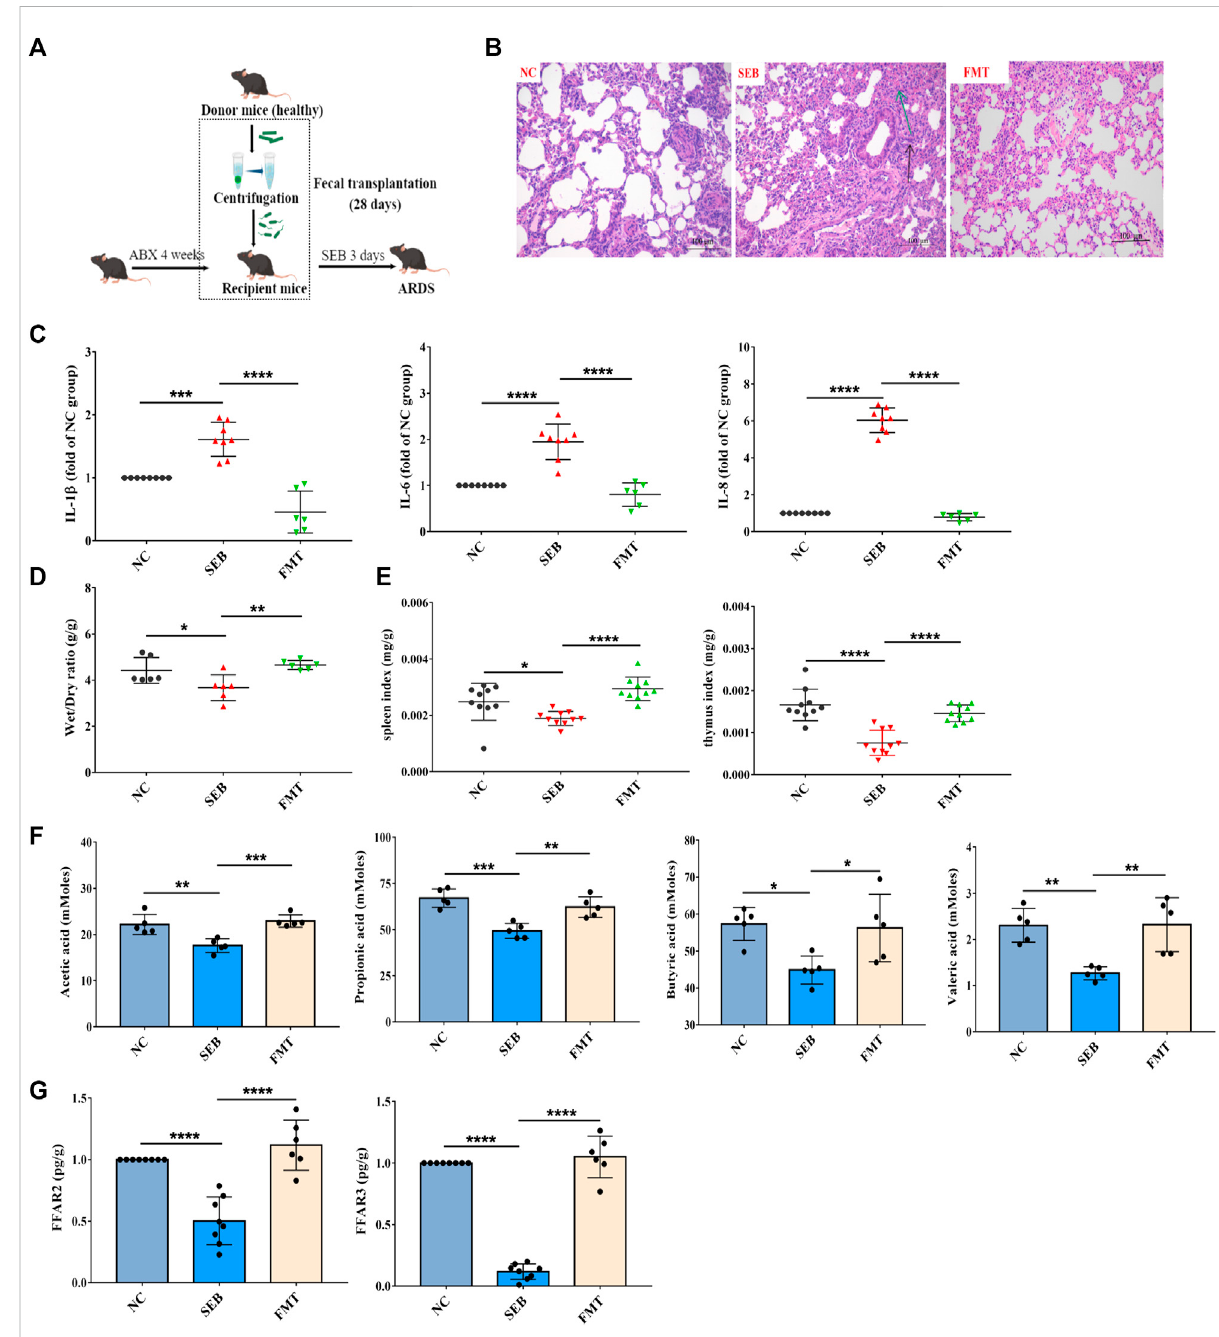
FIGURE 4 Effects offaecal microbiota transplantation (FMT) on microbiota reconstitution andARDS pathogenesis. (A) Schematicdiagram ofFMT inARDS mice. (B) Thepathologicalchangesofparaf fi nsections oflungtissuesweremeasuredbyH&Estaining.Scale=200 μ m. (C) Levelsofthreecytokines from the lung tissue ( n = 6 – 8). (D) The lung wet/dry ratio ( n = 6). (E) The organ index of spleen and thymus ( n = 10). (F) Change of content of acetic acid, propionic acid, butyric acid and valeric acid in the feces ( n = 5). (G) Change of mRNA expression of FFAR3 and FFAR2 ( n = 6 – 8). Data have been presented as means ± SD. Statistical analysis was carried out using one-way ANOVA. * p < 0.05, ** p < 0.01, *** p < 0.001, **** p <